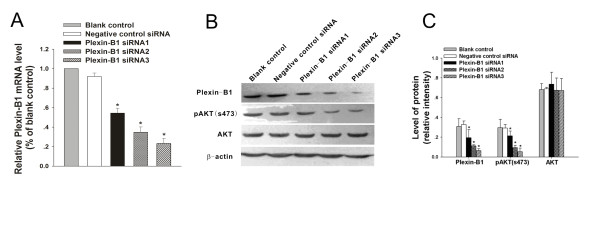
Effects of Plexin-B1 siRNA on SKOV3 cells. (A) Real-time PCR was performed to detect Plexin-B1 mRNA levels in non-transfected cells (Blank control) and cells at 24 h after a 5 h exposure to negative control siRNA or one of the three different Plexin-B1 siRNAs (Plexin-B1 siRNA1-3). The mean relative level ± SD of each group is shown. Plexin-B1 mRNA levels in three Plexin-B1 siRNA groups were significantly down-regulated (*P < 0.01), while the negative control siRNA did not cause an obvious change. The bar graph shows the results of three independent experiments. (B) Western blot analysis of lysates from untransfected (Blank control) SKOV3 cells and SKOV3 cells at 24 h after a 5-h exposure to one of the three different Plexin-B1 siRNAs (Plexin-B1 siRNA1-3) or to negative control siRNA. The cells were analyzed by immunoblotting with specific antibodies to Plexin-B1, p-AKT (s473), AKT and β-actin. Plexin-B1 expression was significantly down-regulated in each of the three Plexin-B1 siRNA groups relative to the blank control group or the negative control group. p-AKT (s473) expression sequentially decreased in the three Plexin-B1 siRNA groups, and AKT changed impalpably at the protein level. β-actin was the internal loading control. (C) The western blots were scanned and quantified. Data present densitometric analyses of Plexin-B1, p-AKT (s473) or AKT relative to β-actin for n = 5 independent experiments. * indicates P < 0.01 when compared to the blank control.